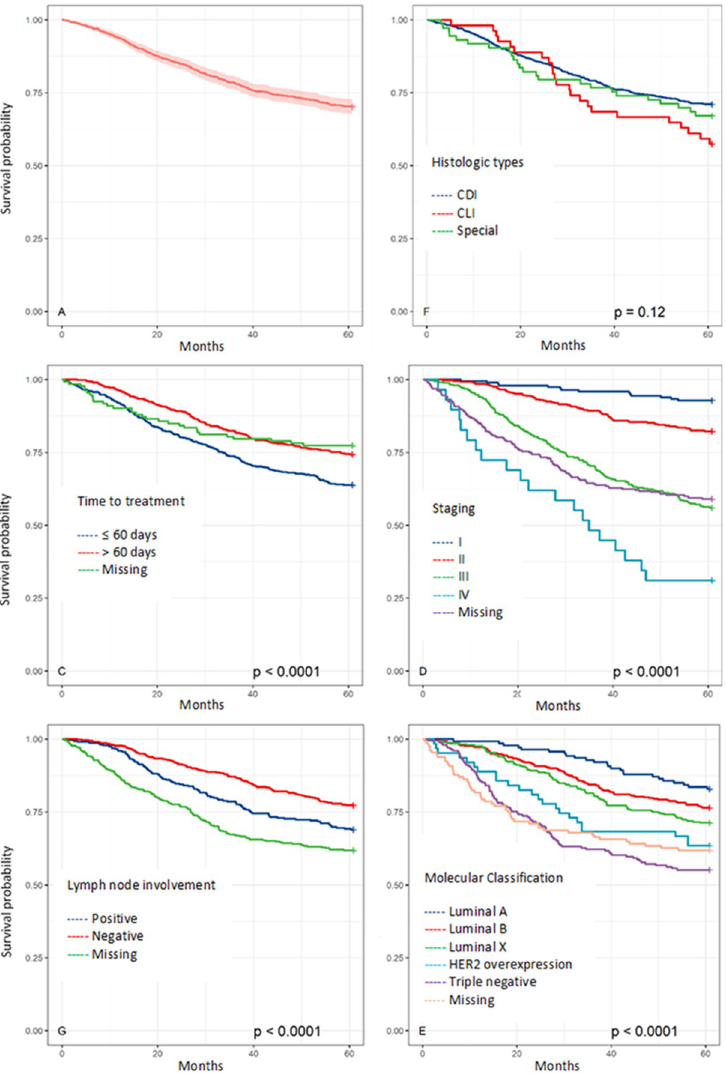
Fig 1. Overall survival and mean overall survival of breast cancer patients by histology type, time to treatment, staging, lymph node involvement, and molecular classification.